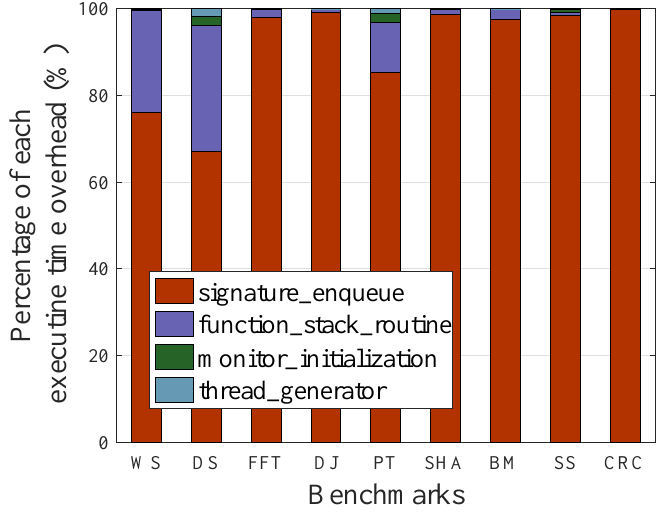
Figure 10. Percentage of each execution time